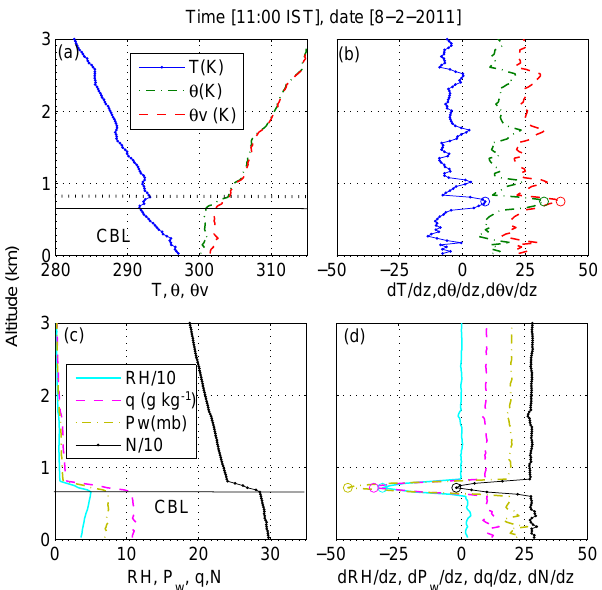
Figure 2. Typical profiles of (a) temperature ( T ), potential temper- ature ( θ ), and virtual potential temperature ( θ v ) as well as (c) rel- ative humidity (RH), specific humidity ( q ), water vapor pressure ( P w ), and radio refractivity ( N ), showing convective boundary layer (CBL) using GPS radiosonde observation at 11:00IST on 8 Febru- ary 2011 over Gadanki (13.45 ◦ N, 79.2 ◦ E). (b) and (d) show the gradient profiles corresponding to (a) and (c) , respectively. Solid horizontal lines in (a) and (c) indicate the base of the inversion layer. Dotted line in (a) indicates the top of the inversion. Open circles in figures (b) and (d) denote the CBL heights above ground